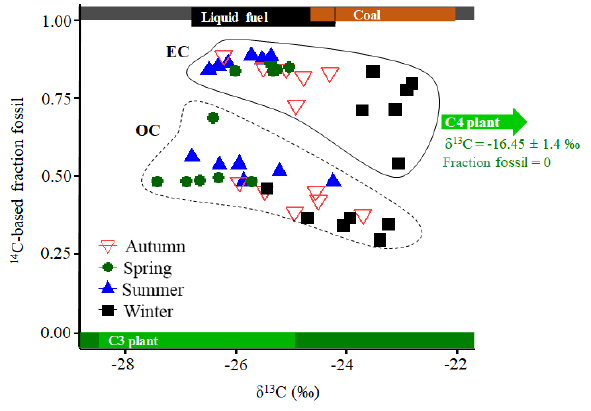
Figure 4. Two-dimensional isotope-based source characterization plot of OC and EC in different seasons. The fraction fossil ( f fossil (EC) and f fossil (OC)) were calculated using radiocarbon data. The expected δ 13 C and 14 C endmember ranges for biomass burning emissions, liquid fossil fuel combustion, and coal combus- tion are shown as green, black, and brown bars, respectively, within the 14 C-based endmember ranges for non-fossil (dark green rectan- gle, bottom) and fossil fuel combustion (grey rectangle, top). The δ 13 C signatures of C 3 plants (green rectangle), liquid fossil fuel (e.g., oil, diesel, and gasoline, black rectangle), and coal (brown rectangle) are indicated as mean ± standard deviation in Table S1. The δ 13 C signature of C 4 plants burning is − 16 . 4 ± 1 . 4‰ and is not shown on the x